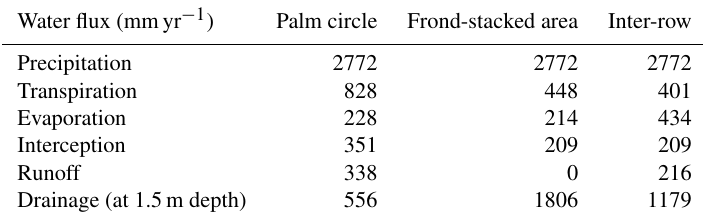
Table 2. Annual water balance simulated from March 2017 to February 2018 for each management